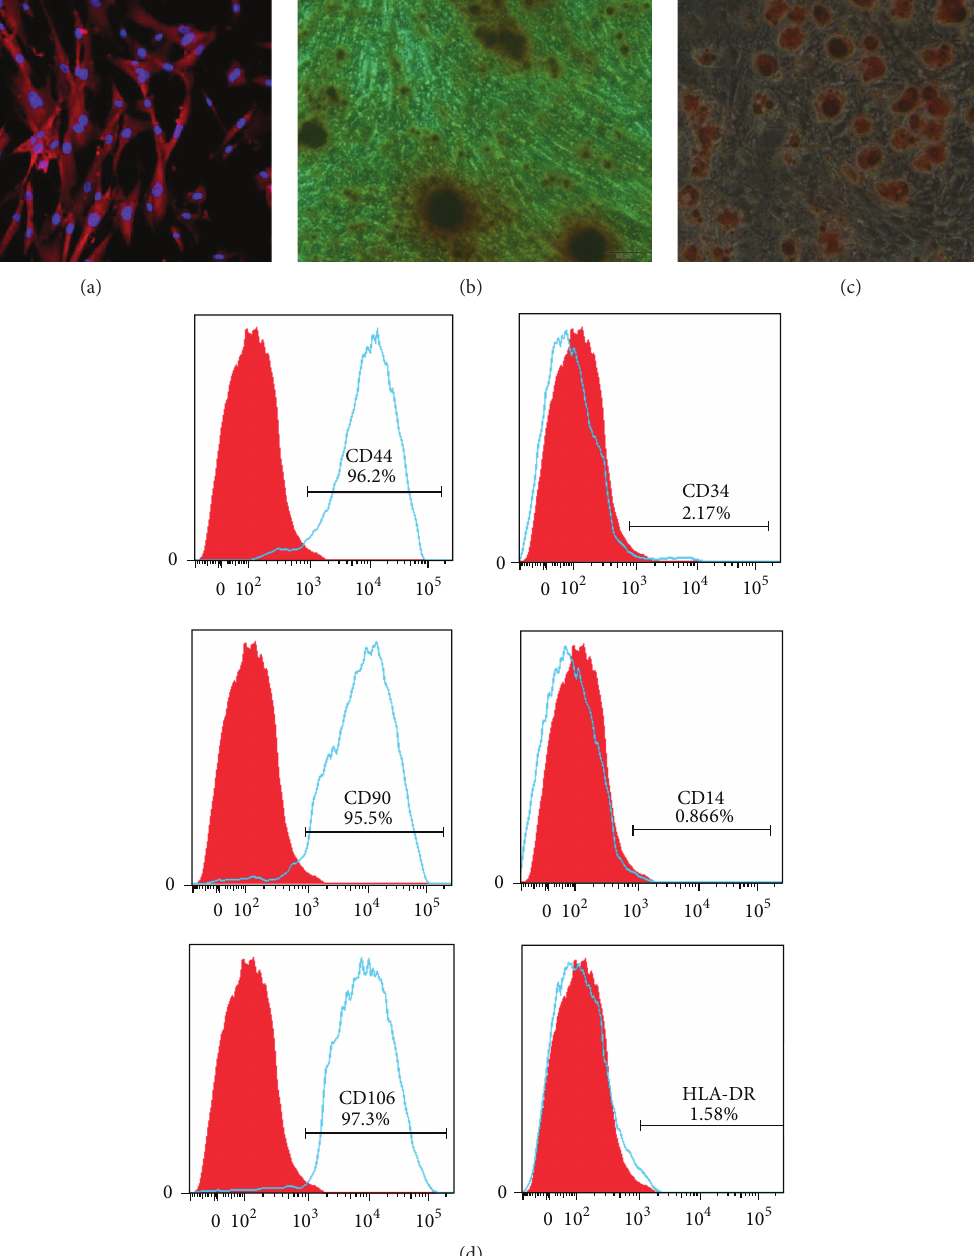
Figure 2: Characterization of human aBMSCs. (a) The aBMSCs expressed STRO-1, a mesenchymal stromal cell marker. Positive staining of the cells with Alizarin red (b) or Oil red O (c) demonstrated the osteogenic and adipogenic differentiation potential of the aBMSCs. Magnification: × 400. (d) The aBMSCs were positive for MSC markers, including CD44, CD90, and CD106, and negative for hematopoietic and endothelial markers, including CD14, CD34, and